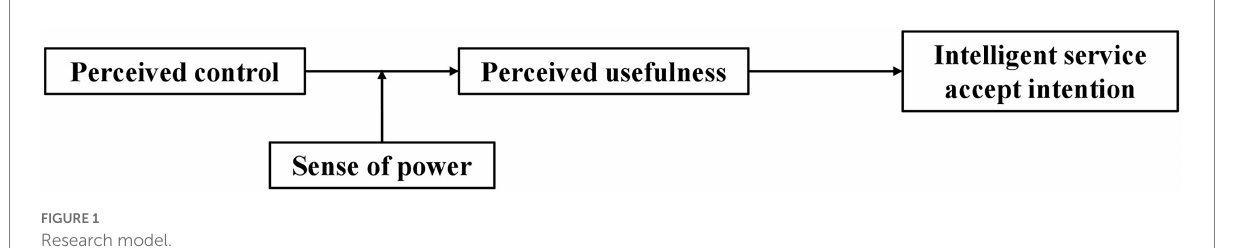
FIGURE 1 Research